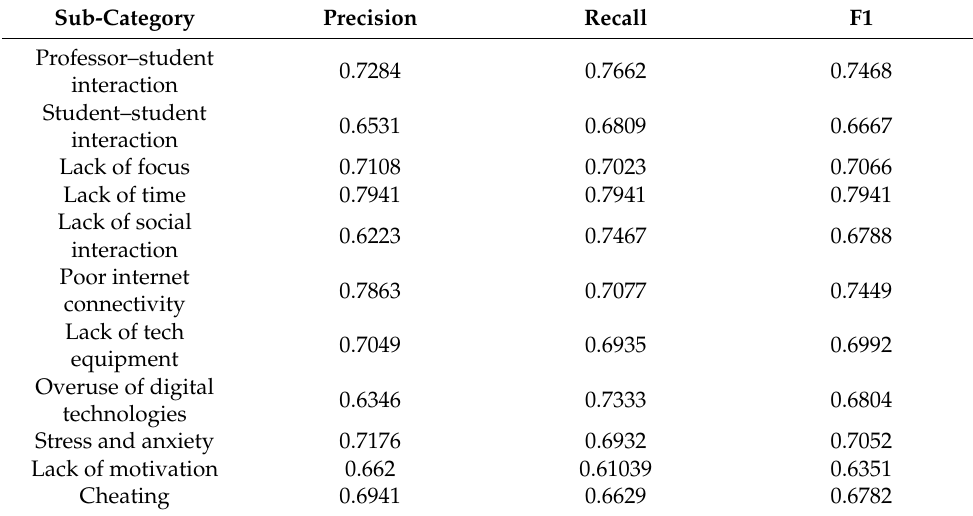
Table 7. Evaluation measures with SVM for each sub-category.